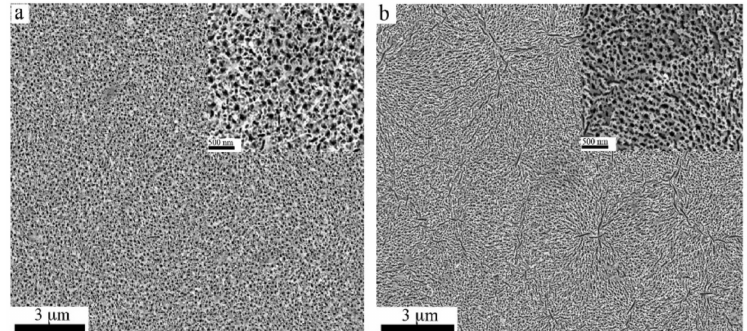
Figure 1. SEM of the porous GaN nanostructures prepared using electroless chemical etching technique: ( a ) for 45 min and ( b ) for 90 min. The insets are the zoom-in windows. Reproduced from [48], with permission from Copyright American Institute of Physics,